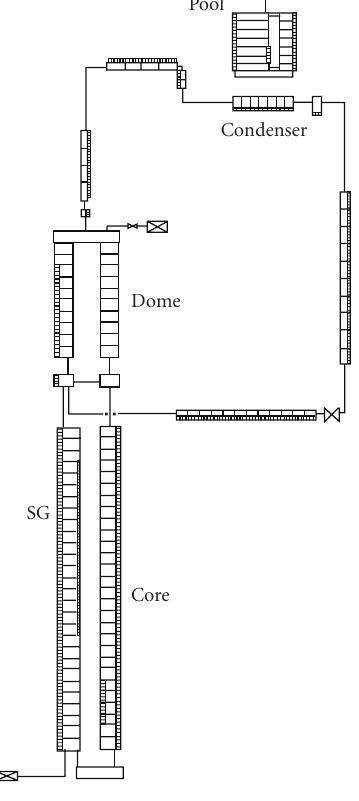
Figure 4: Simplified RELAP 5 nodalization for case